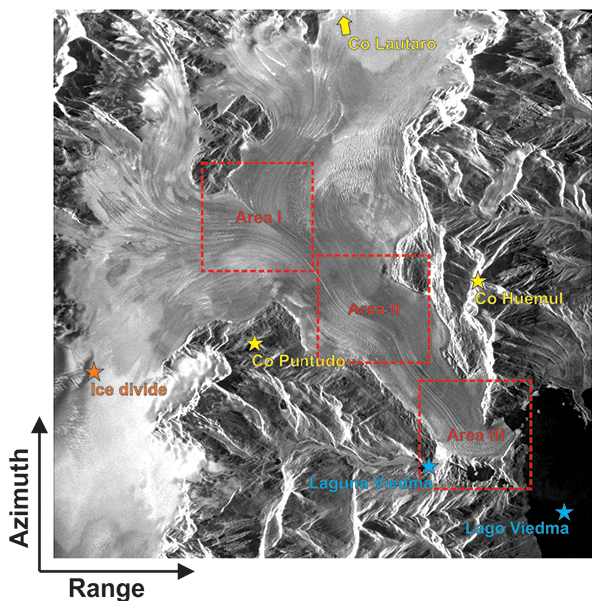
Fig. 4. Amplitude image corresponding to the scene acquired on 15 June 2012 ascending pass. Some reference points have been identified by using coloured stars. Dashed square boxes indicate the areas over the Viedma glacier that have been